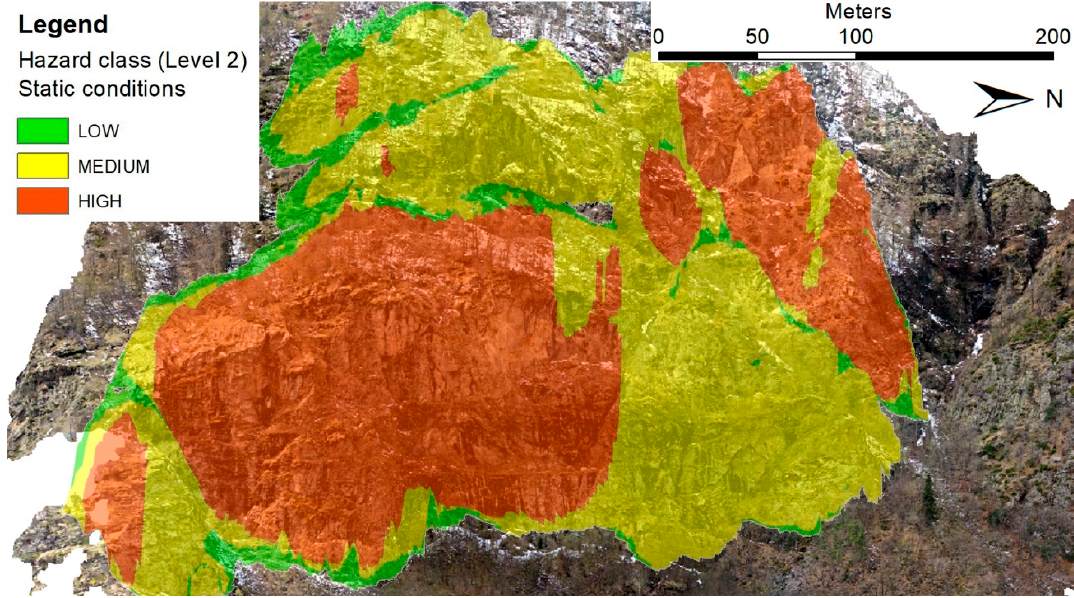
Remote Sens. 2022 , 14 , x FOR PEER REVIEW Figure 11. Frontal view of the Level 2 hazard map (static conditions). Figure 11. Frontal view of the Level 2 hazard map (static conditions).